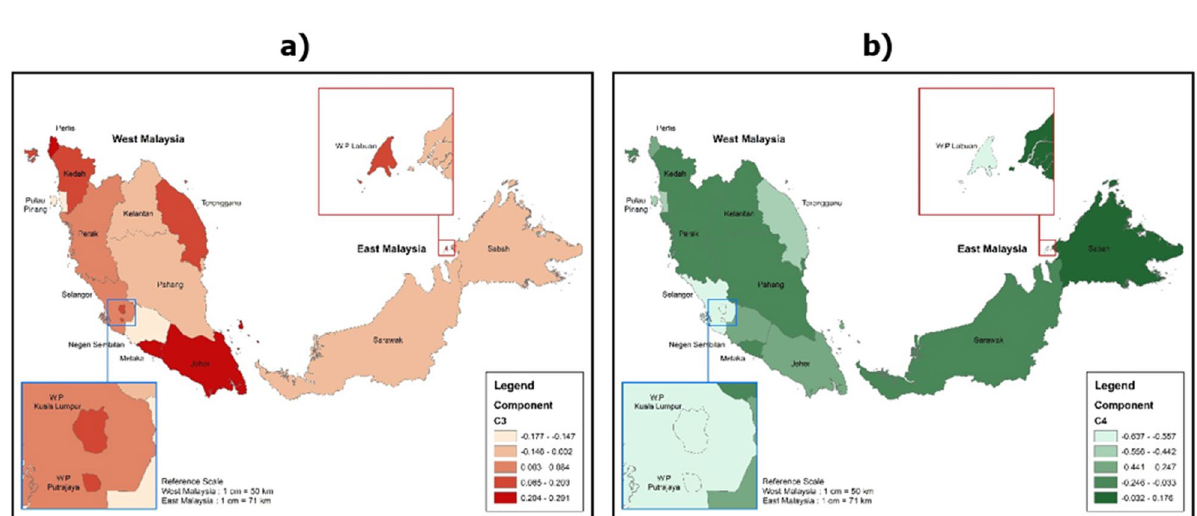
Figure 2. Challenges of e-learning from the aspect of the decreased focus on learning and physical health problems (the images were generated and modified from open source ‘Malaysia—Subnational Administrative Boundaries’ (https:// data. humda ta. org/ datas et/ cod- ab- mys) using ArcGIS Desktop 10.8.1 (https:// www. esri. com/ en- us/ arcgis/ produ cts/ arcgis- deskt op/ overv iew).